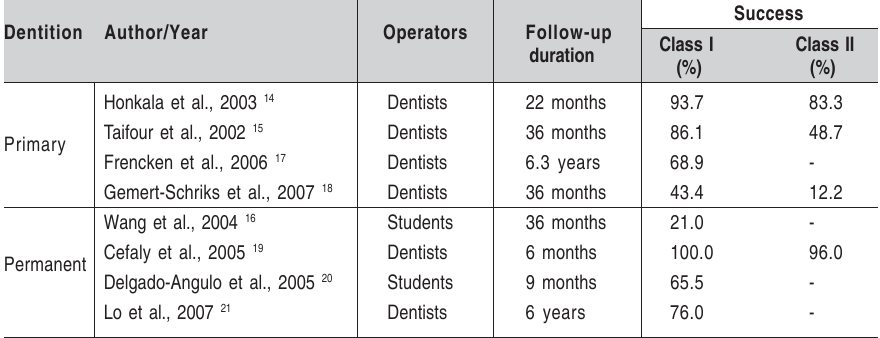
Table 1: Overview of some studies in according to qualification of operator and survival of